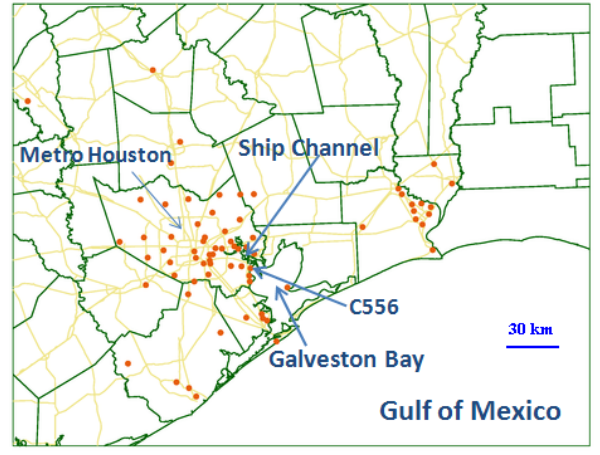
Figure 1. Locations of CAMS sites (dots) in CMAQ 4km model- ing domain during September 2013. Metro Houston, Houston Ship Channel, Galveston Bay, and Gulf of Mexico are